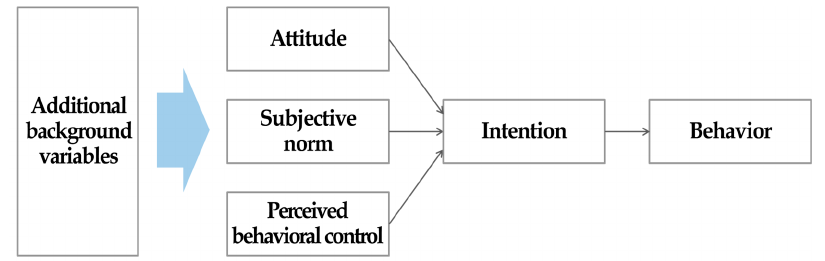
Figure 1. Theory of planned behavior with additional background variables as precursor variables (Hennessy et al., 2010) [18]. (Hennessy et al., 2010)